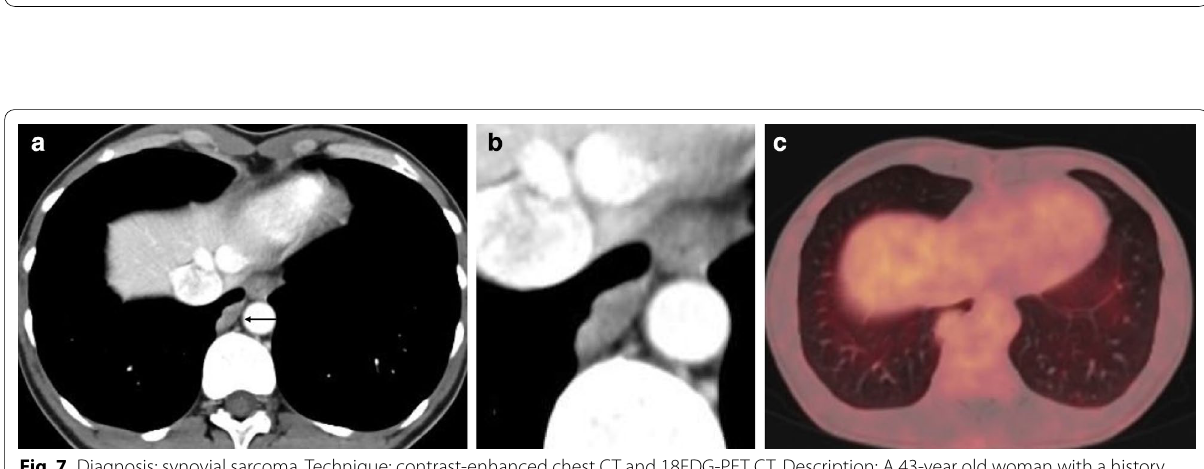
Fig. 7 Diagnosis: synovial sarcoma. Technique: contrast-enhanced chest CT and 18FDG-PET CT. Description: A 43-year old woman with a history of a synovial sarcoma in the sartorius muscle was referred for a chest CT to rule out metastatic disease. Axial contrast-enhanced CT ( a ) shows a lobulated, well-defined pleural lesion (arrow) in the base of the right lung, which is slightly heterogeneous (see detail image b ). There is no increased FDG uptake on the 18-F-FDG PET examination ( c ). Histopathologic examination of the resected specimen confirmed the diagnosis of synovial